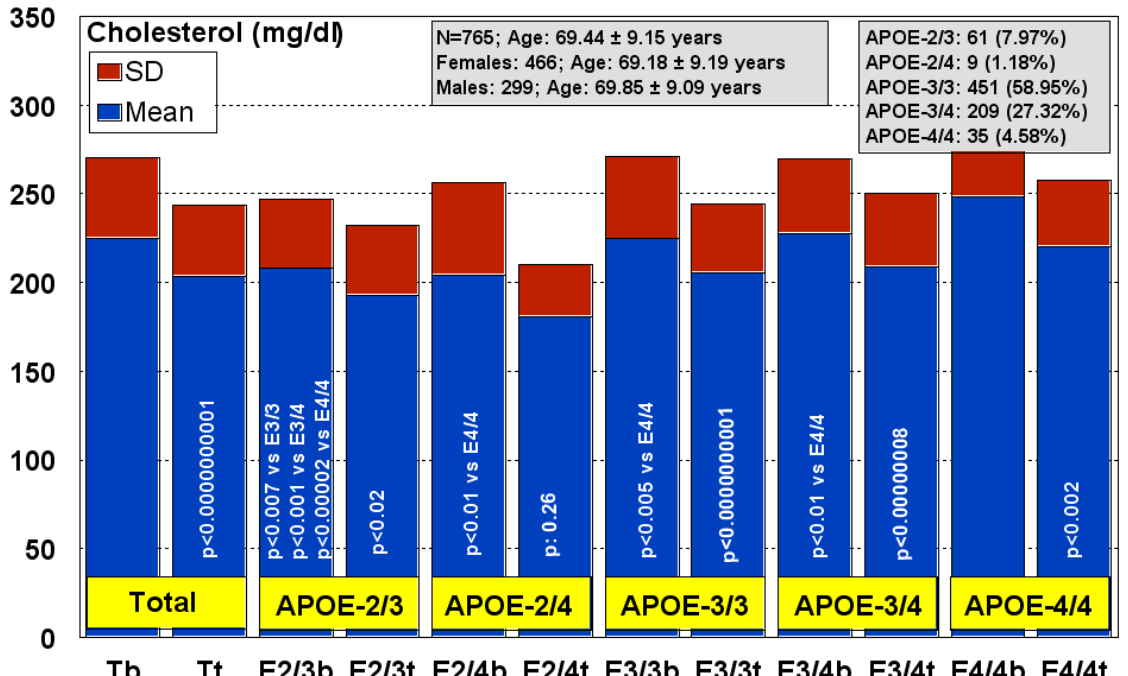
Figure 1. APOE -Related total cholesterol levels response to a multifactorial therapy in patients with